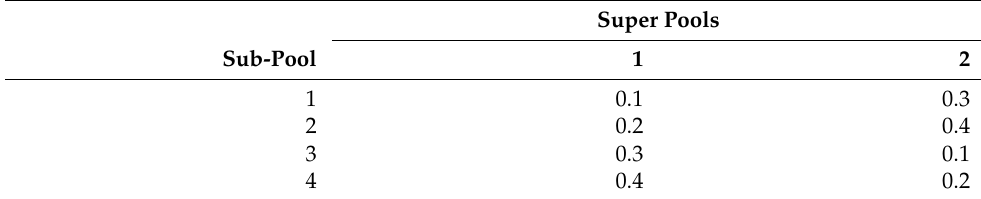
Table A1. Sub-pool contributions to super pools.